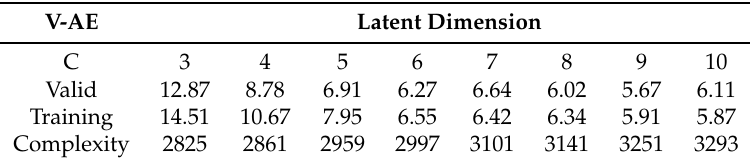
Table 3. Loss values of Variational Autoencoder Training.